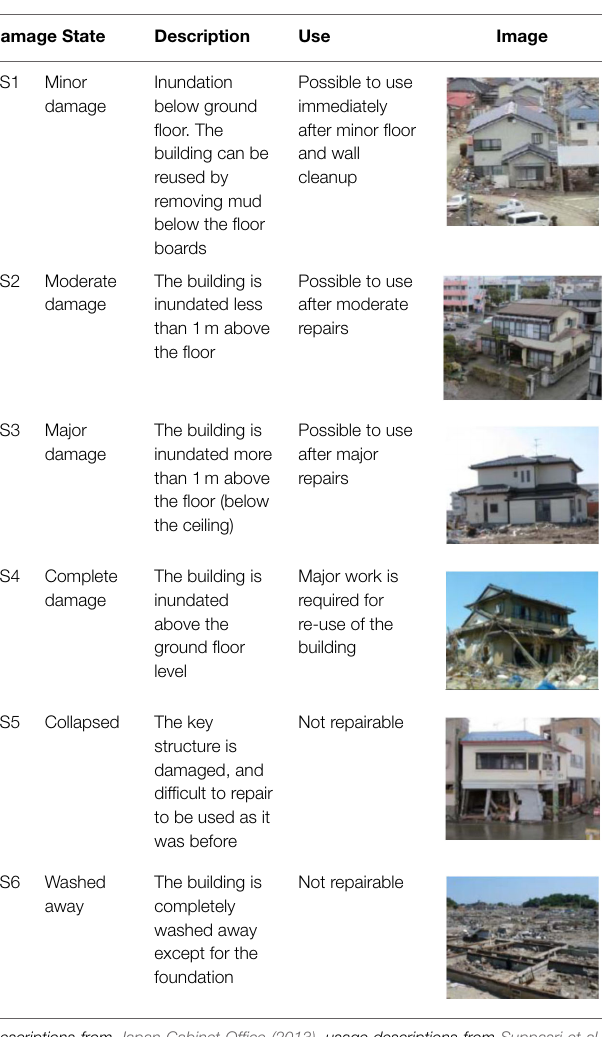
TABLE 5 | Damage state definitions used by the Japanese Ministry of Land Infras- tructure Tourism and Transport following the 2011 Great East Japan Earthquake and Tsunami.